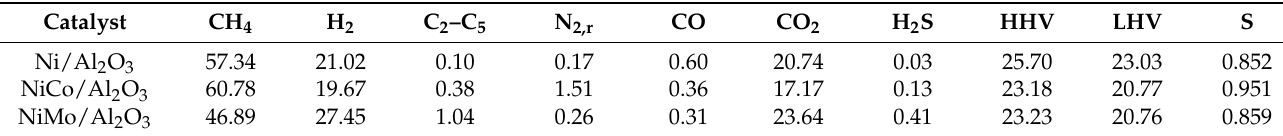
Table 6. Composition of the resulting gas from catalyzed pressure pyrolysis of apricot stones (vol.%). HHV—higher heating value, LHV—lower heating value (both MJ/kg), S—gas density (kg/m 3 ).